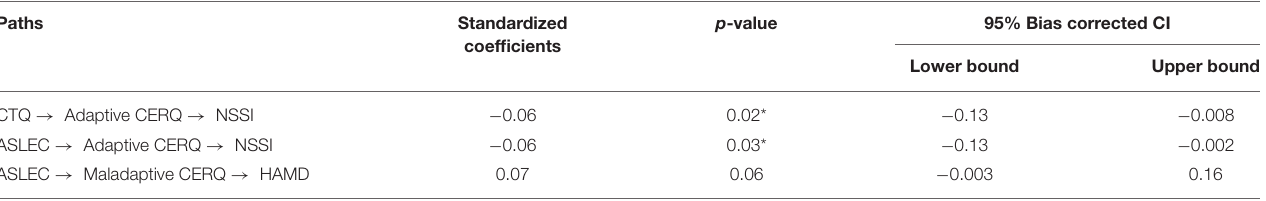
TABLE 5 | The indirect effects in the final model using bootstrapping with 1,000